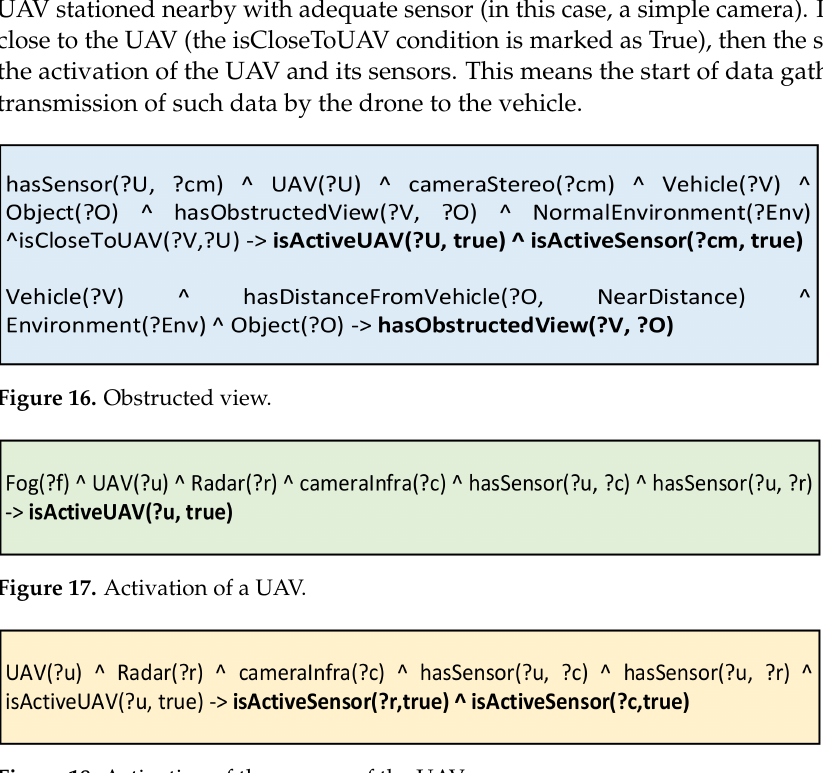
Figure 18. Activation of the sensors of the